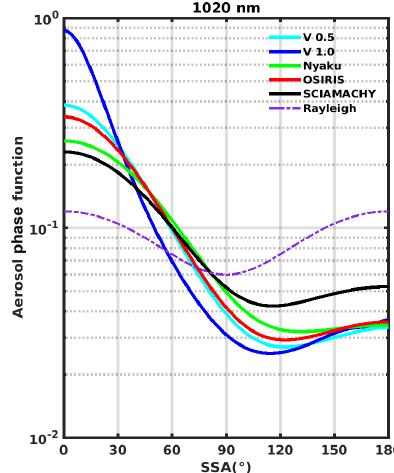
Figure 12. The aerosol phase function at 1020nm as a function of SSA (or (cid:50) ) for the aerosol size distributions listed in Tables